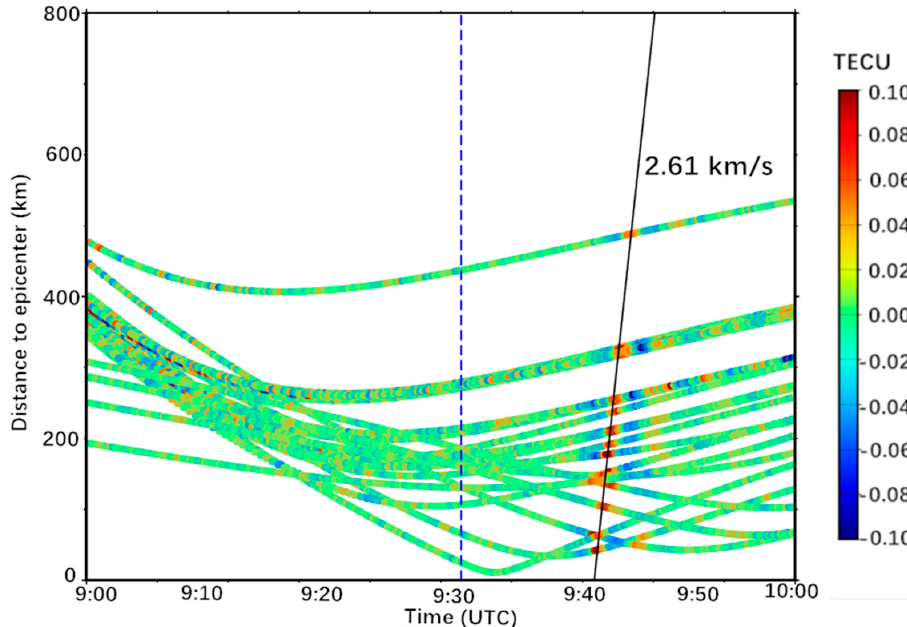
Figure 6. Distance-time diagram of the ionospheric disturbance sequence following the Alaska earthquake, the blue line indicates the time of the earthquake, and the black line represents the trend line fitted according to the peaks of co-seismic ionospheric disturbances (CIDs).